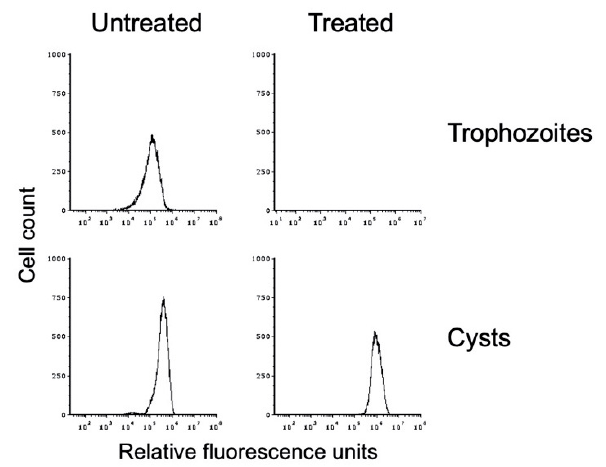
Figure 4. In vitro-formed E. histolytica cysts are detergent resistant. Flow cytometry analysis was performed on E. histolytica cells from standard trophozoite growth (top) and after encystation (bottom). Histograms from untreated cells are shown on the left and from sarkosyl-treated cells on the right. Histograms display cell count versus fluorescence intensity and are representative. Histograms are uniform for direct comparison of the position and size of the peaks. Three biological replicates were performed, and the results shown are representative.